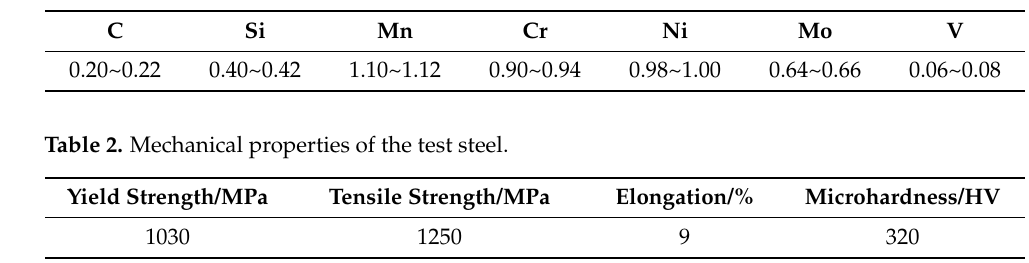
Table 2. Mechanical properties of the test steel.